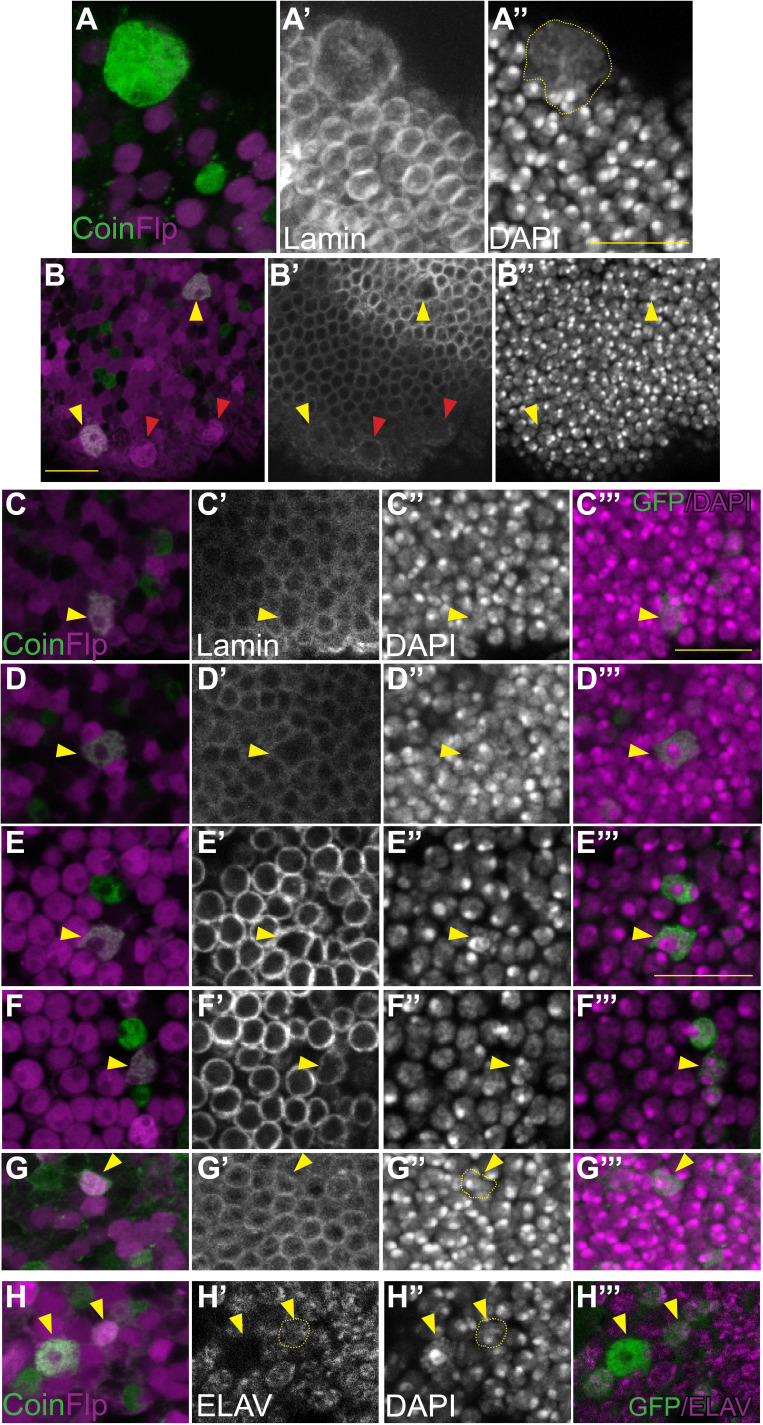
CoinFLP double positive cells are polyploid.Heat-shock induced CoinFLP was used to stochastically label cells in the adult brain with UAS-GFPNLS (magenta), LexAop-RFPNLS (green), or both 24 hr prior to dissection. Optic lobes at 14 days (A–G) or 7 days (H) are shown. Projections of three one micron z-sections (A,B) or single z-sections (C–H) with anti-lamin and DAPI staining were used to delineate nuclear boundaries and quantify DNA content (Figure 4—figure supplement 2A). (A) Very large polyploid cells likely to be sub-perineurial glia, are easily discernible on the surface of optic lobes. (B) Visibly larger polyploid cells scattered throughout optic lobes are double-labeled with CoinFLP (yellow arrowheads) but can also be single-labeled (e.g. expressing UAS-RFPNLS/UAS RFPNLS, magenta arrowhead) due to the stochastic nature of CoinFLP labeling. (C–G) Arrowheads indicate examples of double-labeled CoinFLP cells. All were confirmed to be polyploid by Dapi quantifications (Figure 4—figure supplement 2A). Polyploid nuclei can exhibit a visibly dispersed chromocenter (C), intact chromocenters with decondensed peripheral chromatin (D,E) multiple chromocenters (F) or a normal nuclear appearance (G). (H) An example of a double-labeled CoinFLP, ELAV positive cell, confirmed to be tetraploid by Dapi quantification (yellow arrowhead) with a neighboring double-labeled CoinFLP, ELAV negative polyploid cell (white arrowhead). Scale bar = 10 µm.